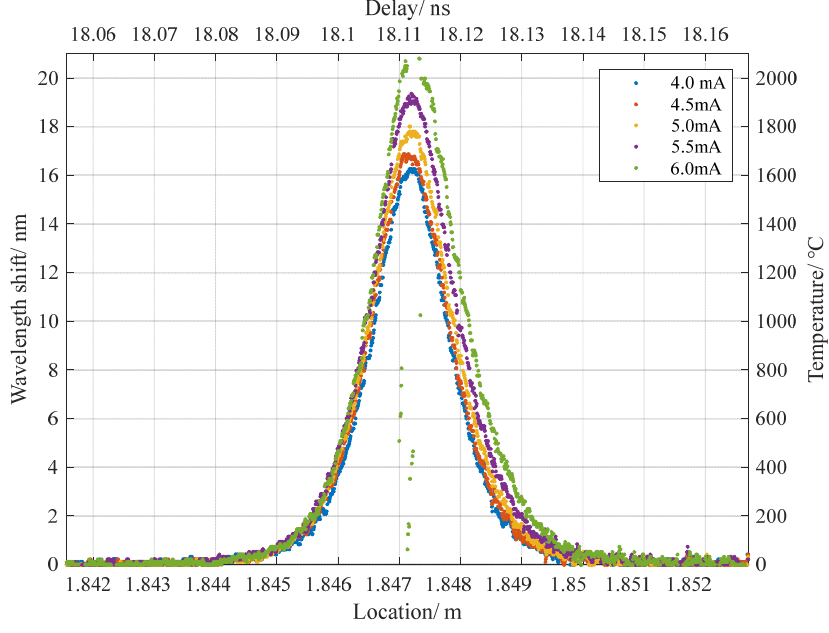
Figure 3. Distributed temperature profile varied with five selected currents along the fiber.